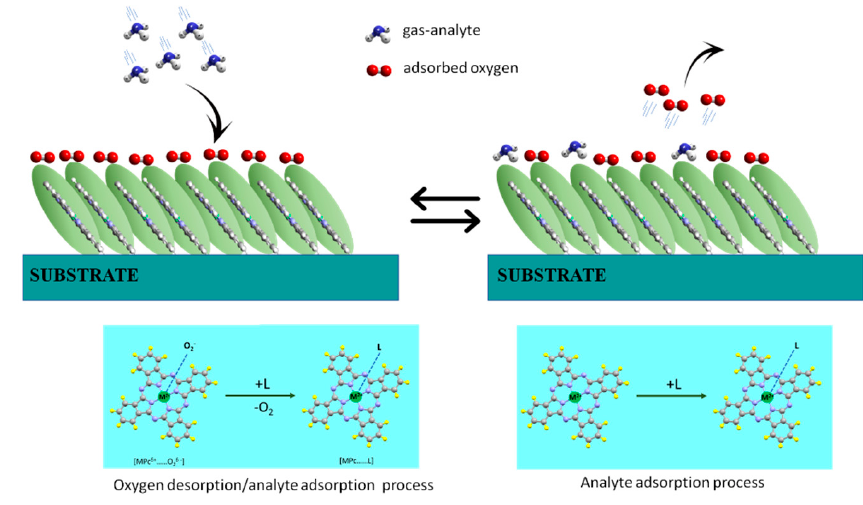
Figure 3. Schematic diagram of the sensing mechanisms of MPc sensors.